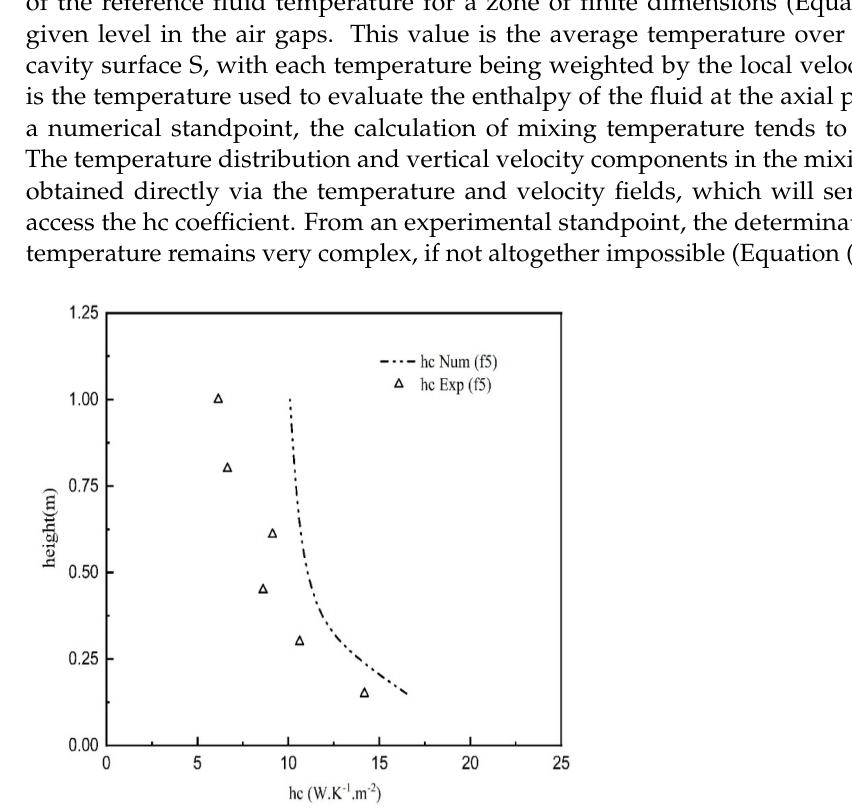
Figure 21. Convective heat transfer coefficient, using Equations (11) and